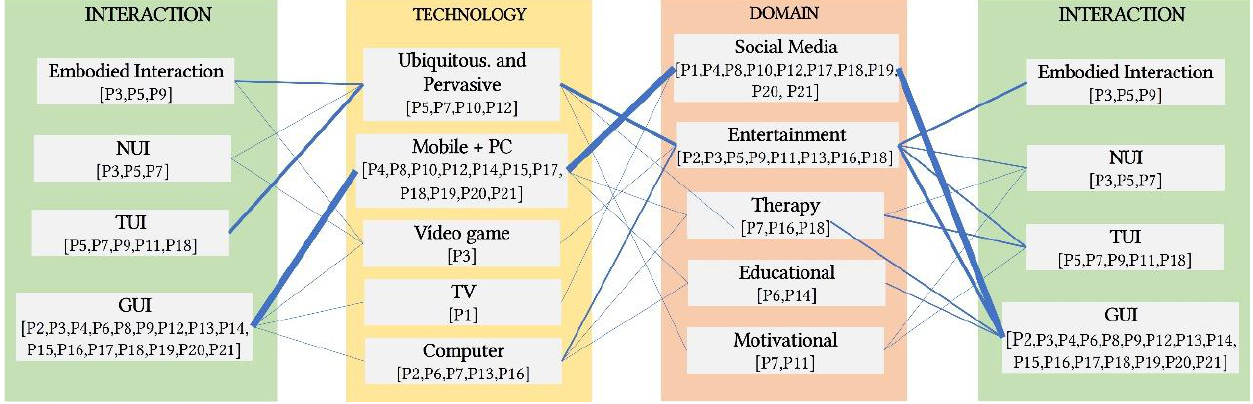
Figure 3. Correlation among technology, domain, and interaction